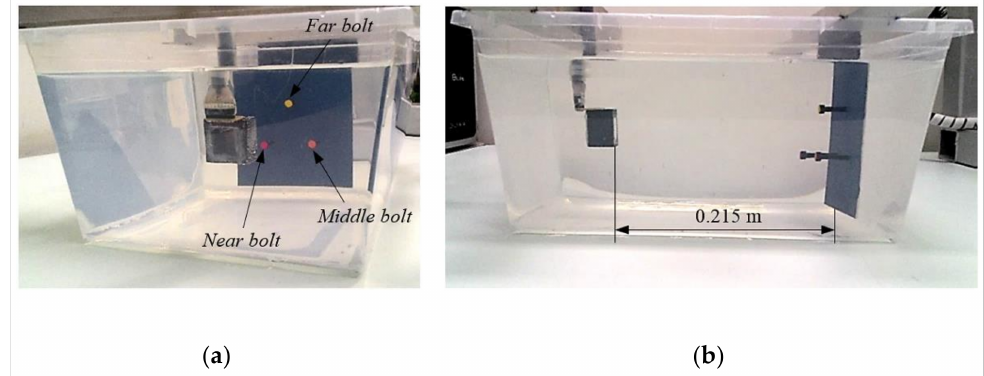
Figure 18. ( a ) Front view and ( b ) Side view of the three-dimensional experiment using three steel bolts at 120 ◦ between them. The height of the red, orange, and yellow bolts are 35, 30 and 25 mm, respectively, and the diameter is 8.5 mm ( ≈ 2.5 λ